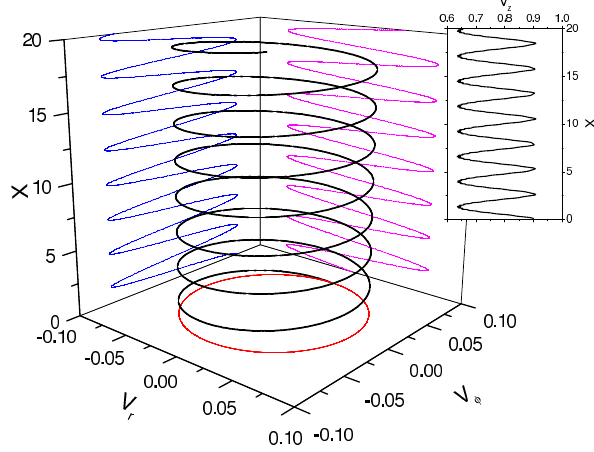
Fig. 6. Features of propagation velocity of a solitary wave under the reference set of data but with V z0 = 0 . 9. In the perpendicular plane in velocity space, V r and V φ form a helical motion versus X , while V z has only a unidirectional propagation along X as shown in the inserted panel. All the three velocity components have a common IA period of X 1 = 2 . 63, or, ω 1 = 0 .